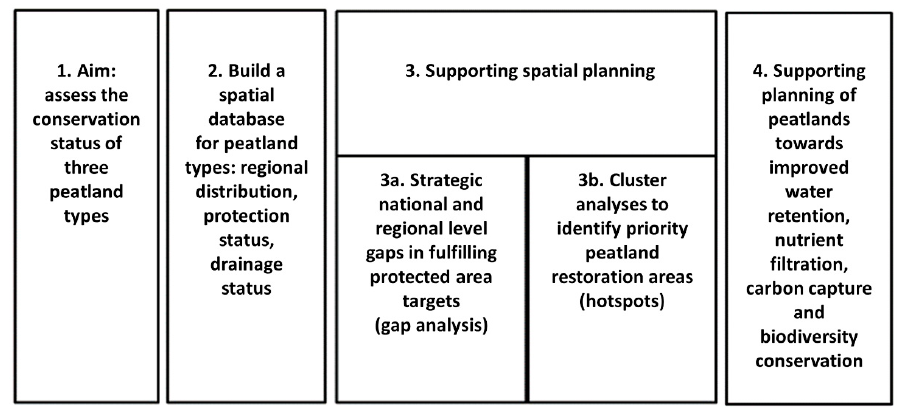
Figure 2. The analytic approach in four steps applied in this study. The strategic planning approach refers to the organizational process of defining high-level directions and making decisions on allocating resources to achieve an overall objective [50]. The cluster analysis aims at serving the subsequent tactical planning in local sub-basins.